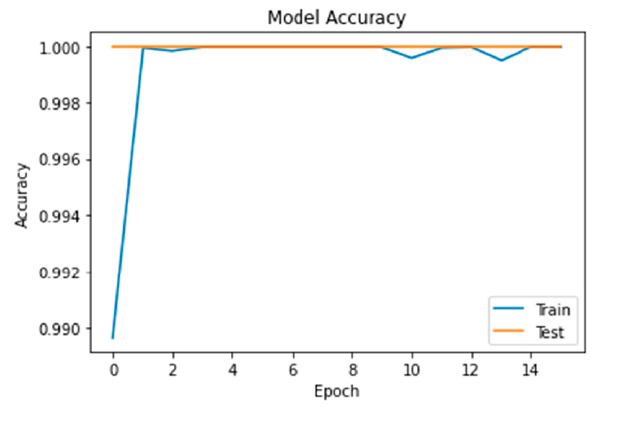
Figure 7. Confusion Matrix of ANN Detection.